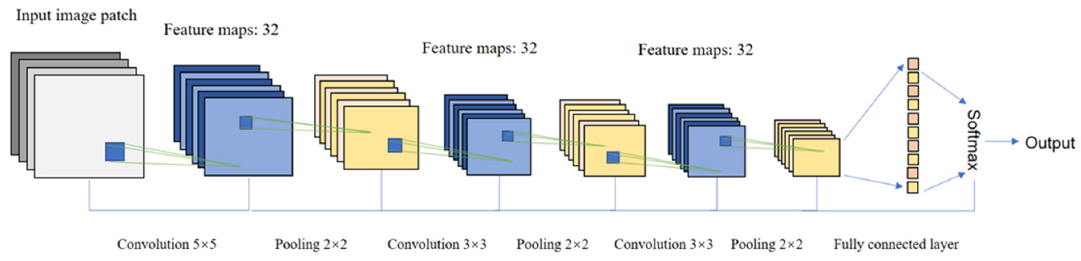
Figure 5. The model structure and parameter settings of the CNN network employed in this